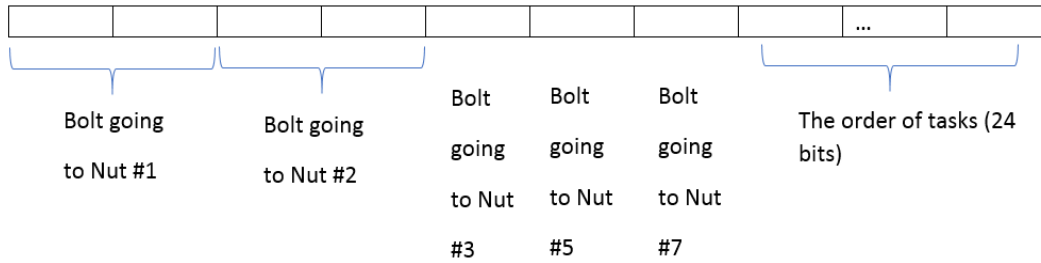
Figure 5. Encoding assembly sequence to a